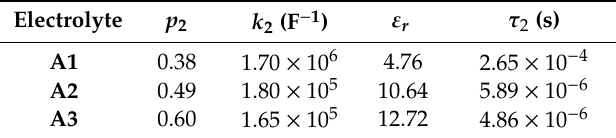
Table 4. The calculated values of p 2 , k 2 , ε r and τ 2 for the electrolyte system.